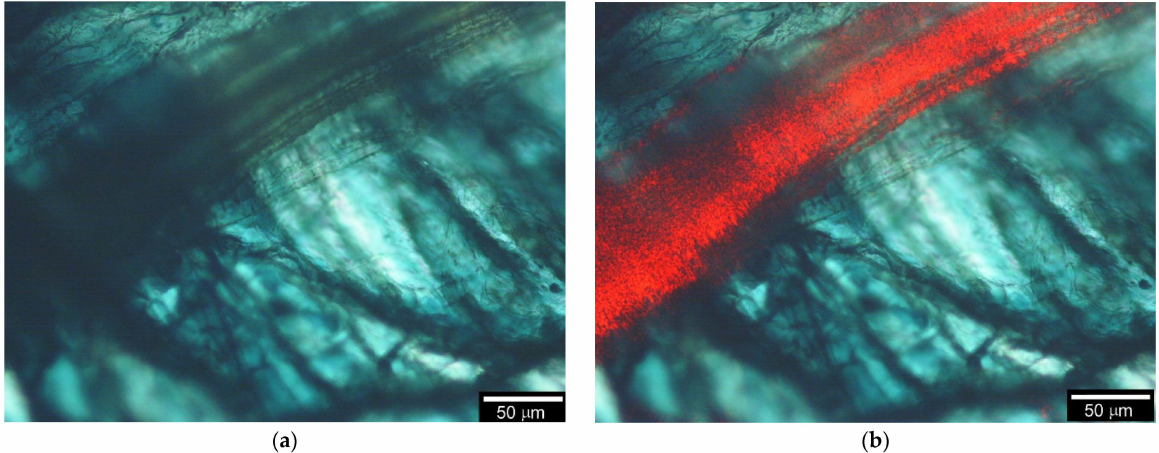
Figure 9. Light conduction function of sprout/PANI composite under ( a ) no light irradiation, and ( b ) light conduction along the sprout/PANI vessel composite upon red laser light